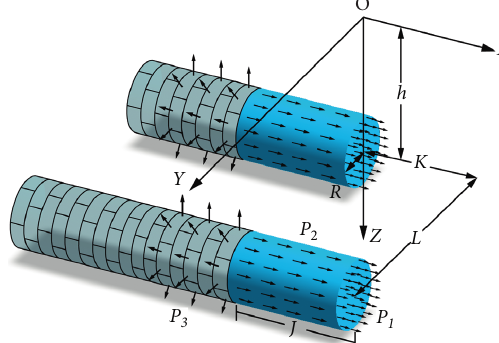
Figure 2: Mechanical calculation model of soil deformation caused by shield